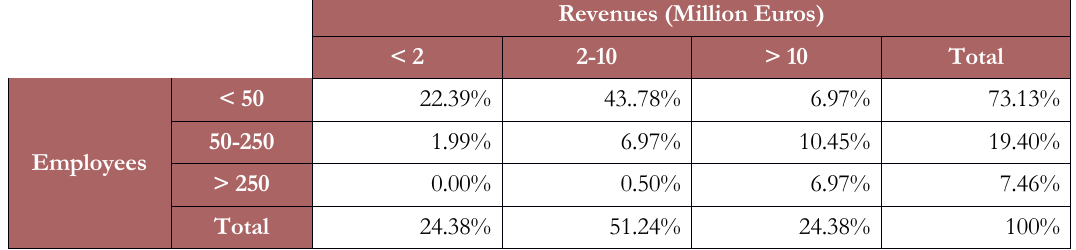
Table 3. Sample description (Revenue and Employees)